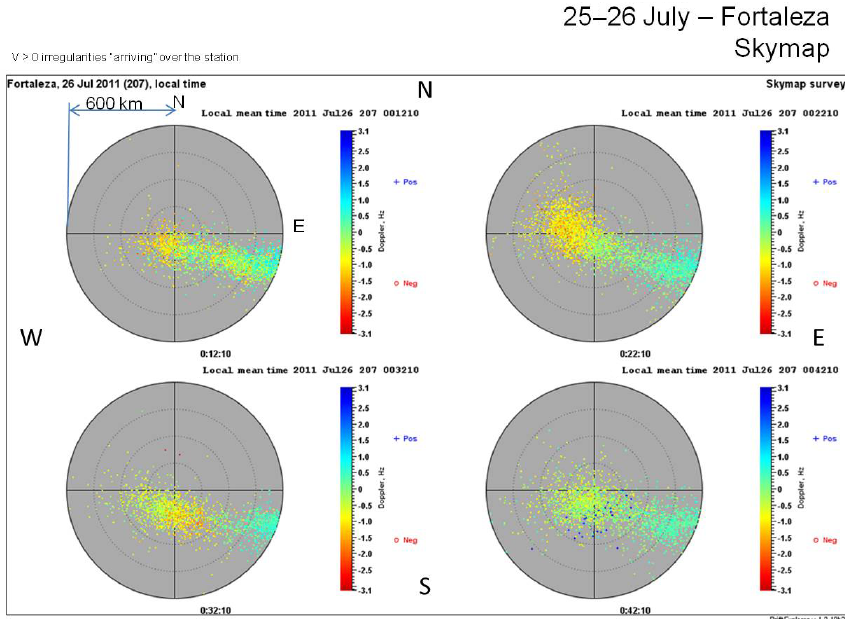
Figure 4. Sky maps registered over FZ from 00:12 to 00:42LT on 26 July 2011, showing the echo locations and Doppler frequencies (color coded) for F-region echoes from digisondes. Doppler velocities are positive (negative) for irregularities arriving (leaving) the